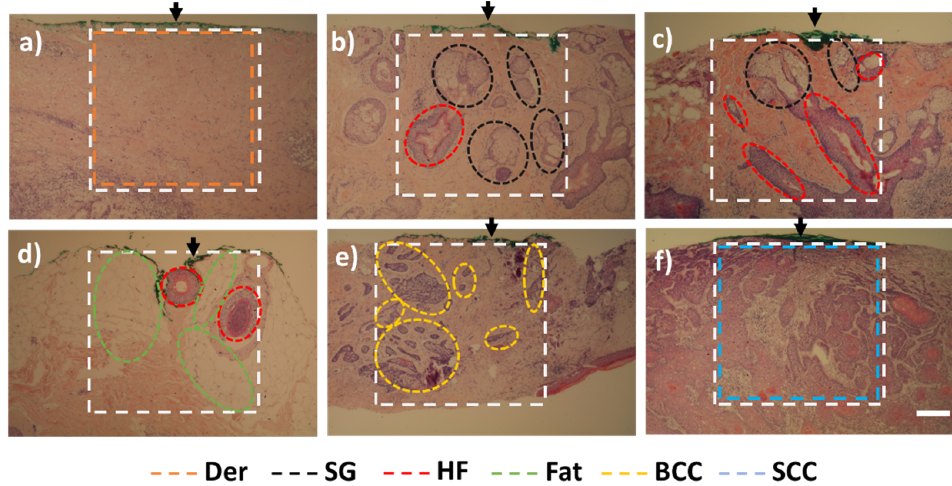
Figure 1. Examples of tissue structure within the sampling area of the fiber probe with the main area of ( a ) dermis (Der), ( b ) sebaceous glands (SG), ( c ) hair follicles (HF), ( d ) fat, ( e ) BCC tumor, and ( f ) SCC tumor. The green dye on skin tissue (marked by the black arrow) shows the location of Raman acquisition, and the white dashed box highlights the sampling area of 1 mm 2 . Scale bar: 200 µ m.